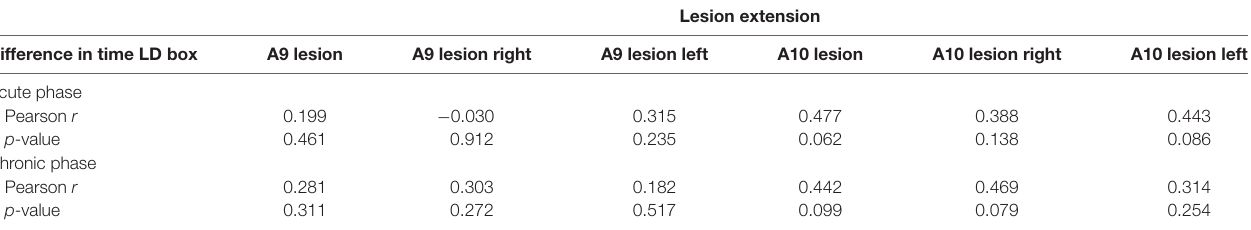
TABLE 2 | Correlation analysis between A9/A10 lesion extent and difference in time in levodopa (LD) box between pre and post-conditioning sessions in the conditioned place preference